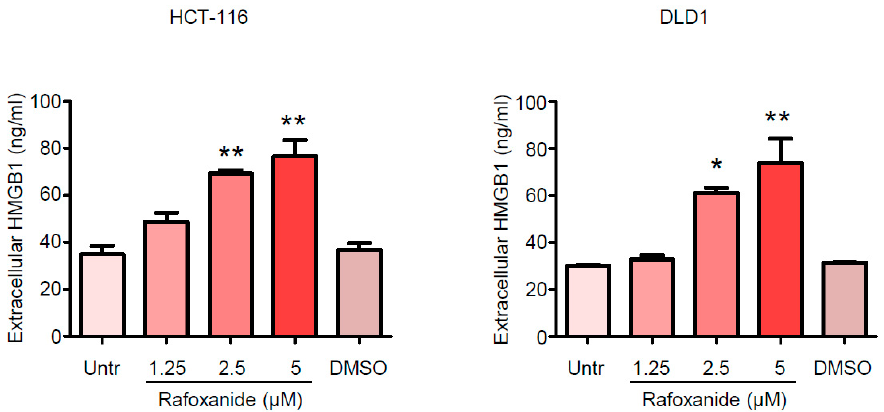
Figure 3. Rafoxanide induces HMGB1 release in CRC cells. Representative histograms showing the amount of released HMGB1 in the medium supernatant of HCT-116 and DLD1 cells either left untreated (Untr) or treated with either DMSO (vehicle) or rafoxanide for 48 h. Data are expressed as mean ± SD of two experiments. Data were analyzed using one-way analysis of variance (ANOVA) followed by Dunnett’s post hoc test. DMSO vs. rafoxanide-treated cells, * p < 0.05, ** p < 0.01.